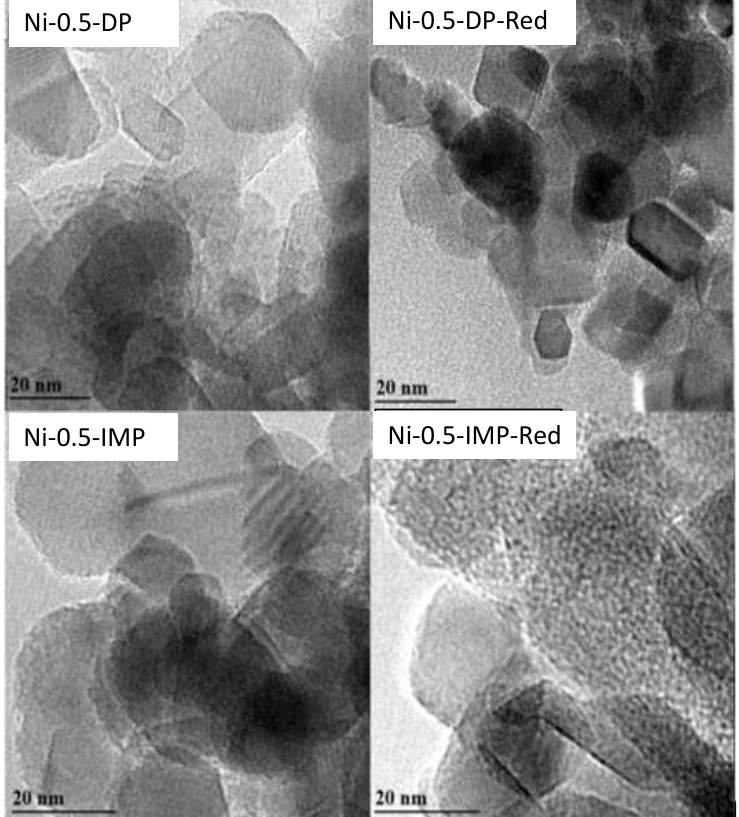
Figure 4. TEM micrographs of the fresh (unused) Ni catalysts.